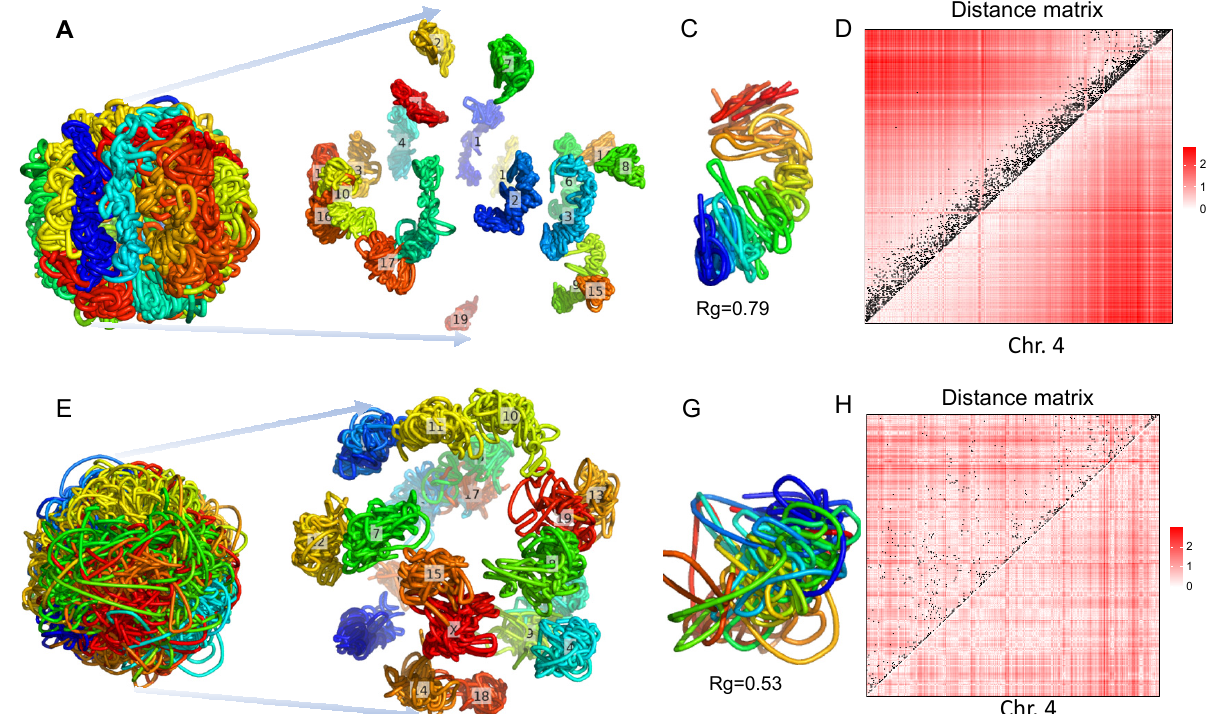
Figure 4. The scHiCEmbed reconstructed 3D genome at 500 kb resolution for one cell in post-M stage ( A – D ) and another cell in G1 stage ( E – H ). ( A , E ) reconstructed 3D structures of whole genomes (chromosomes are labeled in different colors). ( B , F ) expand a nucleus into separate chromosomes. ( C , G ) reconstructed 3D structures of chromosome 4 with their radius of gyrations. ( D , H ) Euclidean distance matrices parsed from reconstructed 3D structures corresponding to ( C , G ), respectively. We overlay raw Hi-C contacts on the distance matrices (black points on heat maps ( D , H )). chromosome 2, 7591 copies of chromosome 21, and 4558 copies of chromosome 21 with